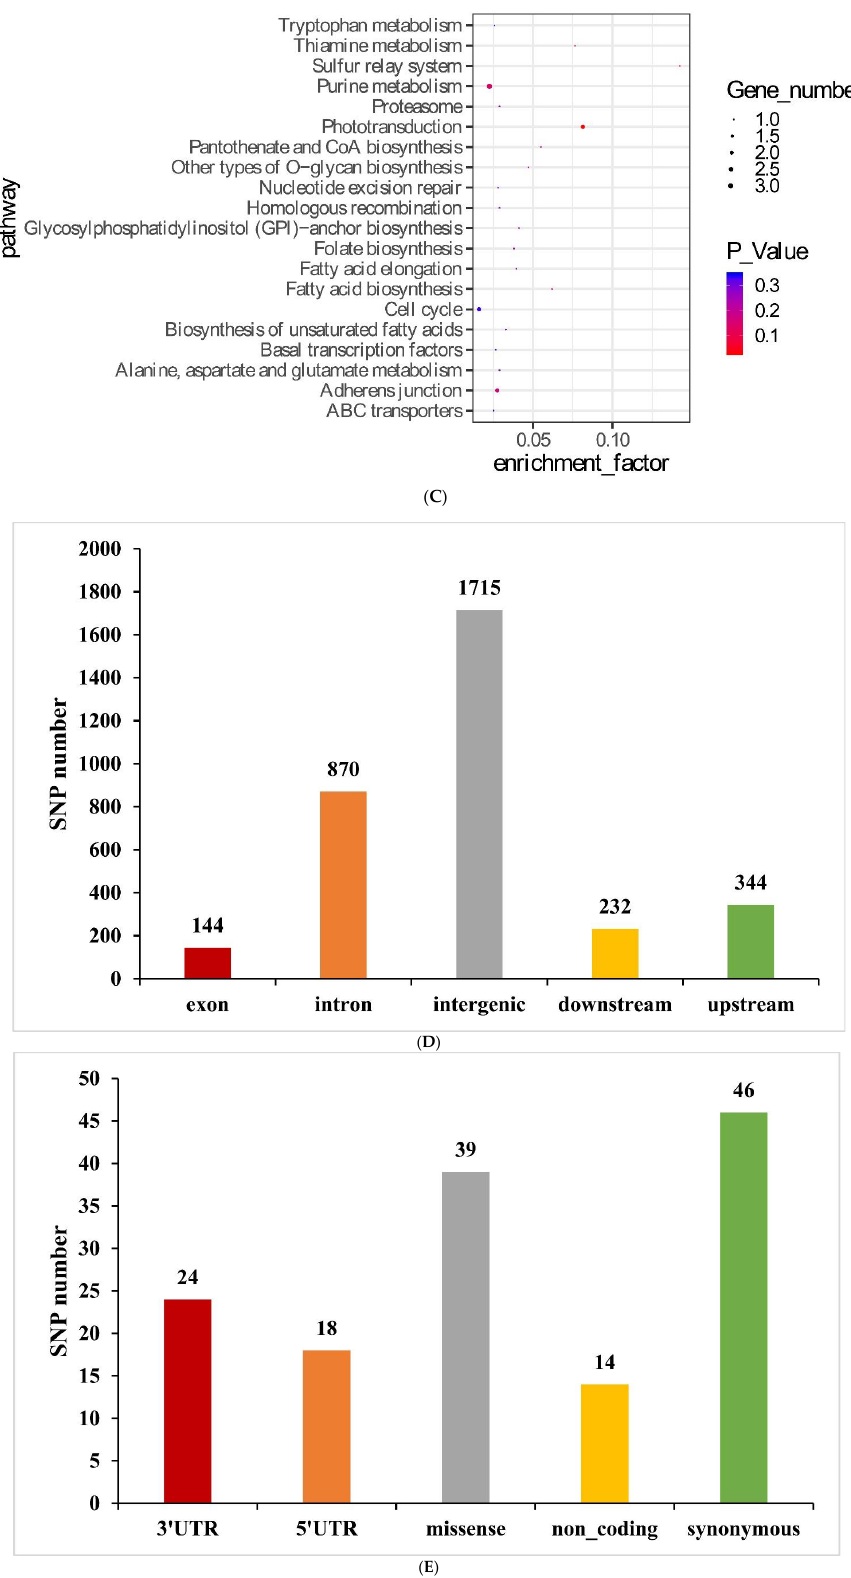
Figure 3. Screening and analysis of candidate SNPs. ( A ) Gene Ontology (GO) analysis for 3.370 can- didate SNPs. ( B ) Level two GO analysis of candidate SNPs. ( C ) KEGG enrichment of candidate SNPs. ( D ) Distribution statistics of candidate SNPs on chromosome positions. ( E ) Classified statistics of candidate SNPs distributed in the